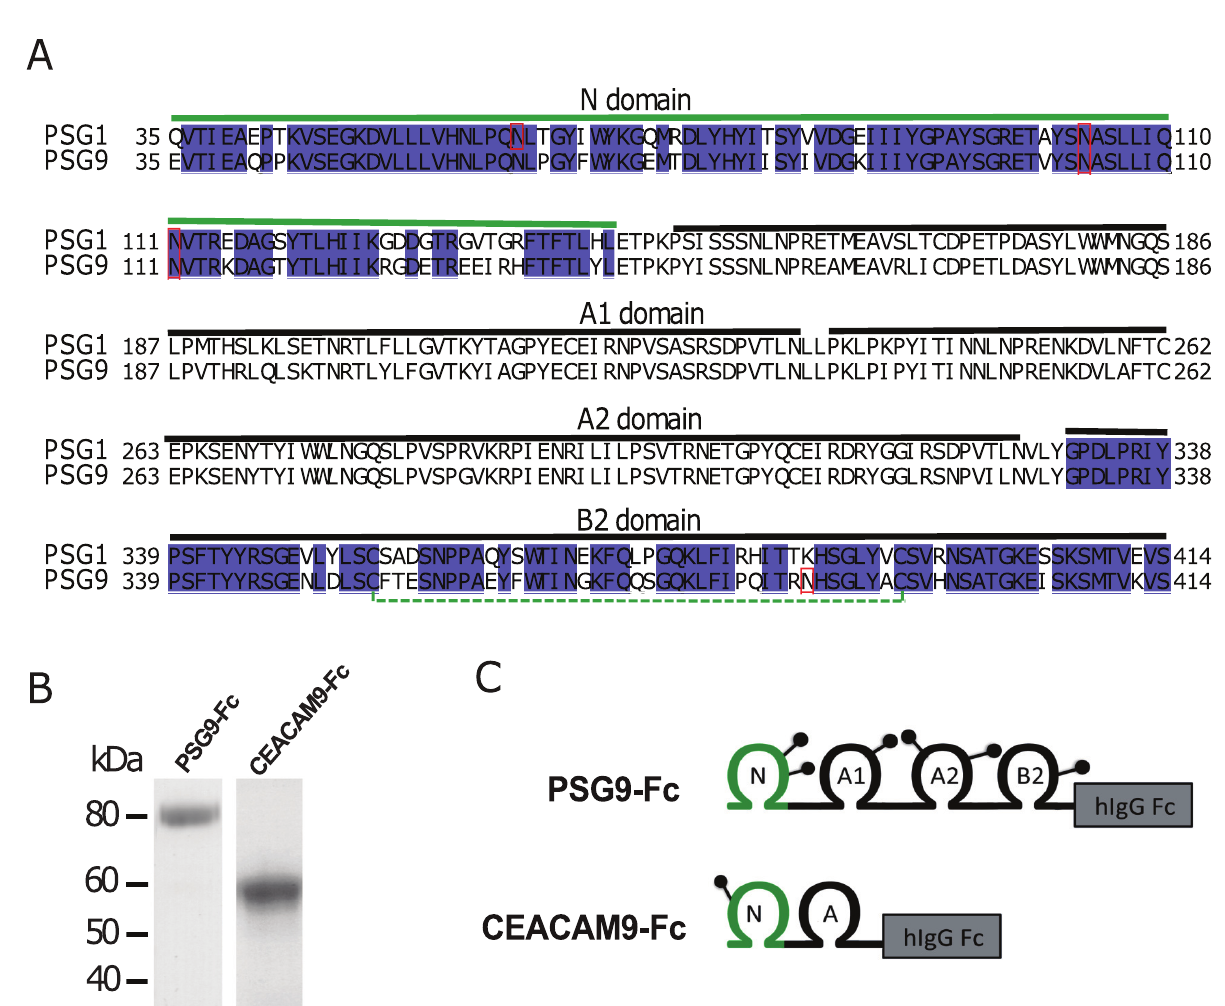
Fig 1. Comparison of PSG1 and PSG9 sequences and depiction of proteins used in the studies. (A) Sequence alignmentof human PSG1 and PSG9 (residues35–415)highlightingthe N and B2 domains sequenceidentity. Sequences corresponding to A1 and A2 domains are also indicated. Potential N-glycosylation sites are boxed in red and the disulfidebond in the B2 domain is marked with a dotted green line. (B) Purified PSG9-Fc and CEACAM9-Fc proteinsproducedin CHO-K1 cells were loadedinto a 4–20% NuPAGE gel. The gel was stained with GelCode Blue to visualizethe proteins. C. Schematicrepresentation of the proteins shown in B. The N-terminal IgV domainand the IgC type domains(A1, A2 and B) are shown. Potential N-linkedglycosylationsites are indicatedas lollipopsand the position of Fc protein tag is representedas a